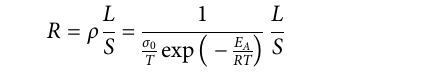
Frontiers in Robotics and AI |